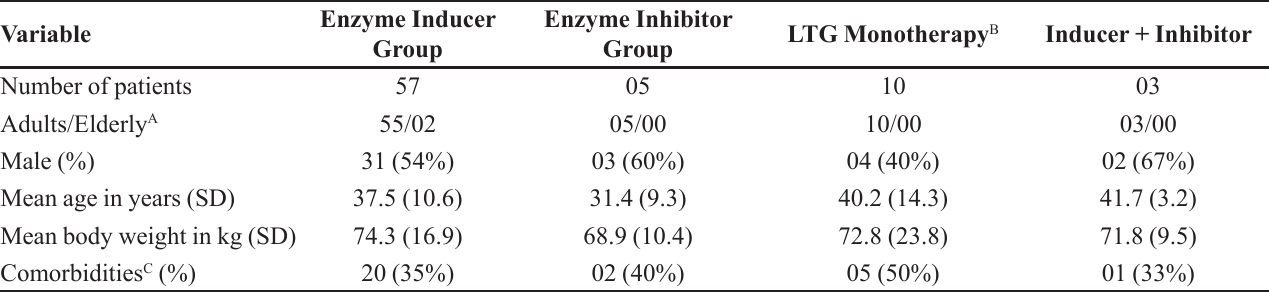
TABLE I - Sociodemographic and clinical features of the patients with refractory epilepsy using lamotrigine at AEDC of HCFMRP- USP on the period of May/2011 until April/2012 (n=75)